Question: Provide a one-line summary of what is displayed.
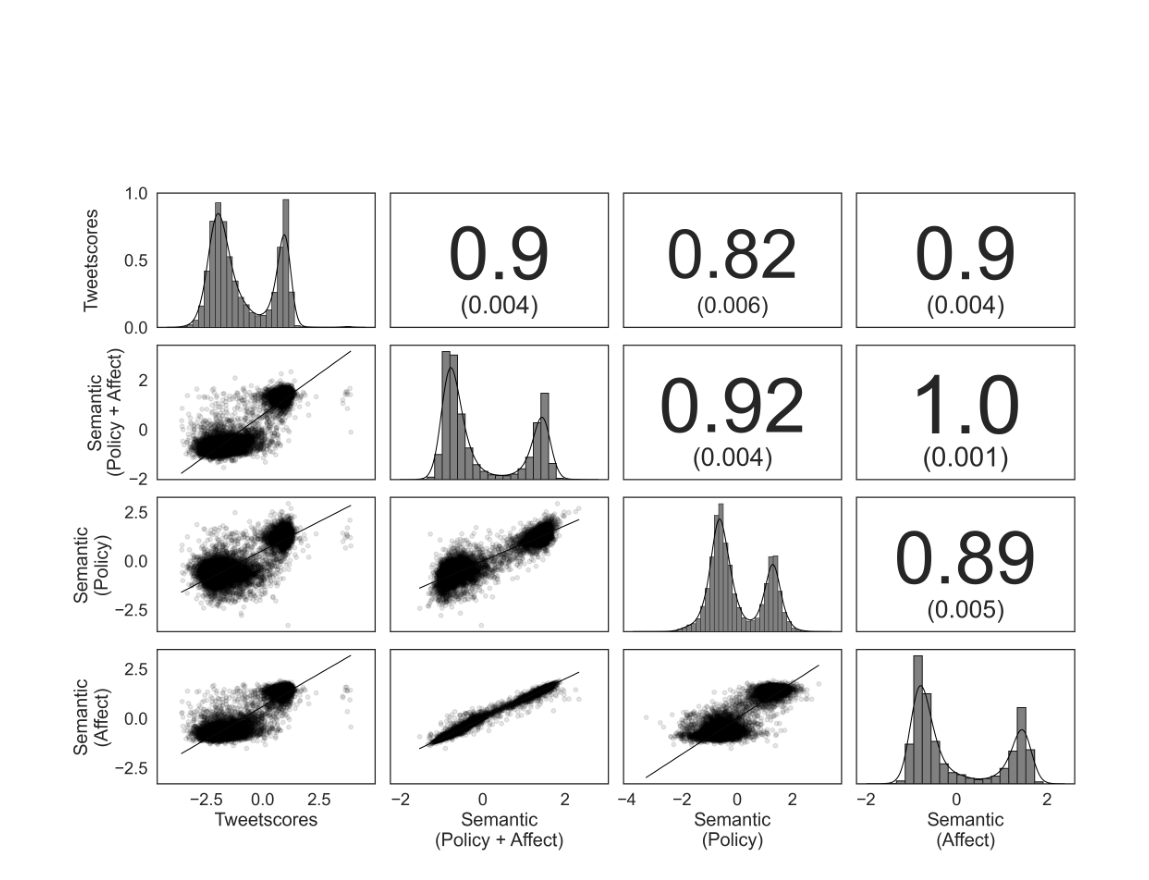
Answer: Semantic Scaling recaptures the bimodal distribution and is highly correlated with Tweetscores.